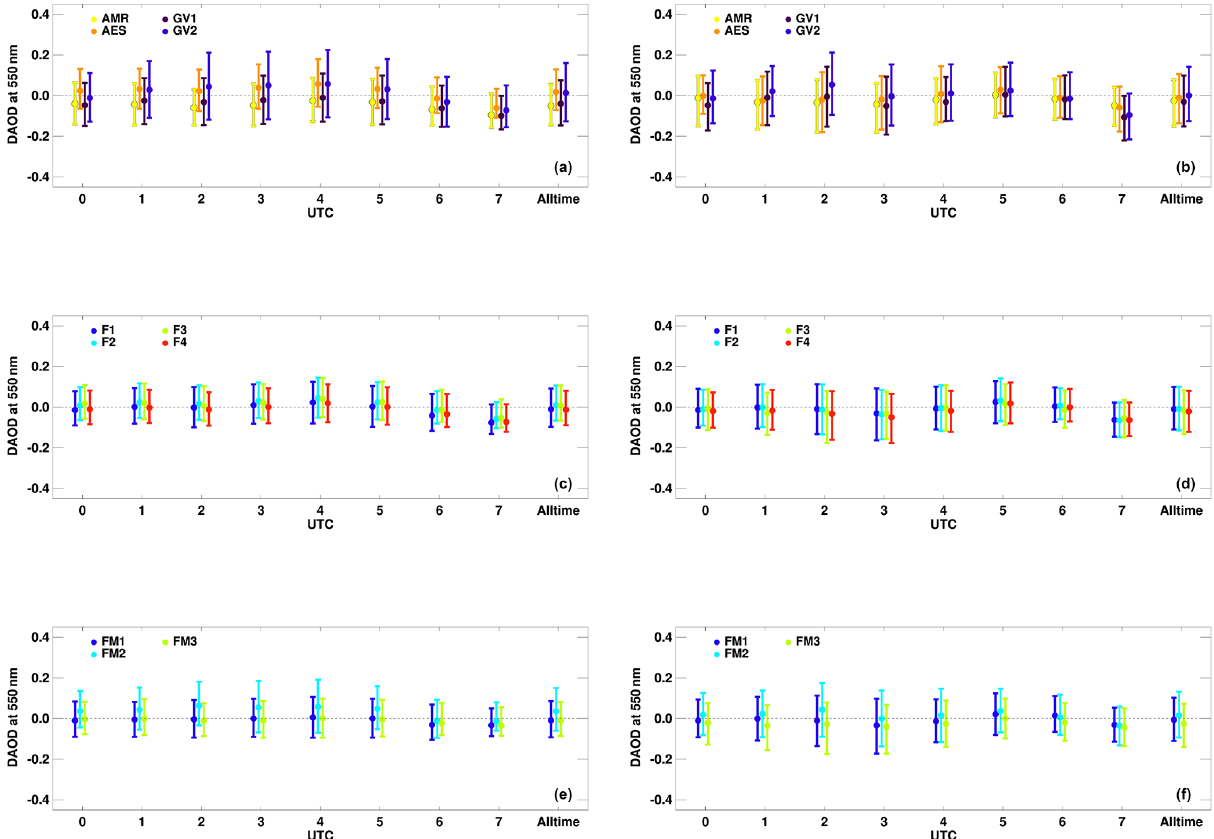
Figure 8. Same as Fig. 7 but for the observation time in